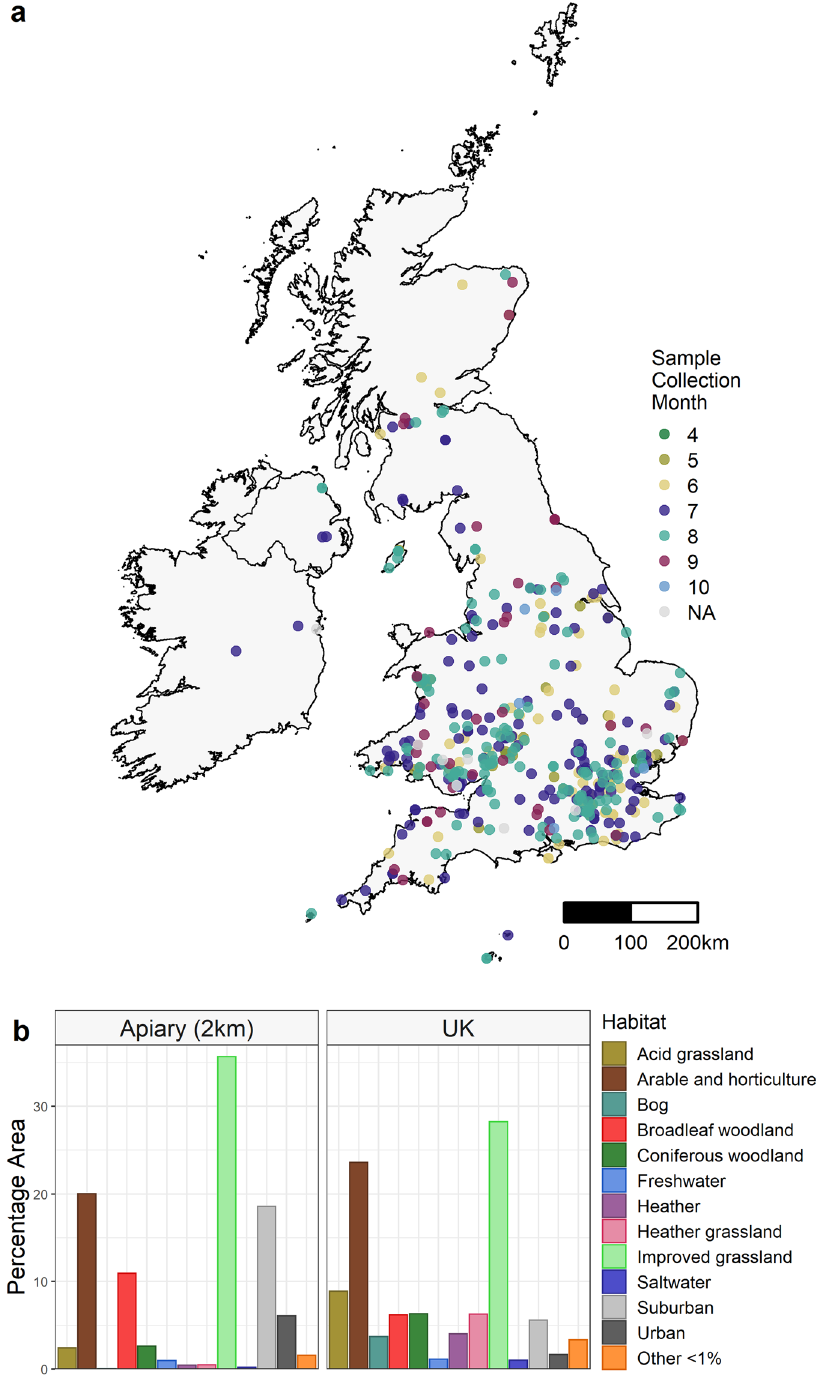
Fig. 1 Distribution of honey samples ( n = 441) collected in 2017 and analysed with DNA metabarcoding, along with the habitat types hives were found within. a The month when honey was extracted from the hive, April (4) to October (10), is indicated by colours. b The percentage area of different habitats is presented for the UK as a whole and for within a 2-km radius of honey samples, characterised using the 2015 CEH Land Cover map (NERC